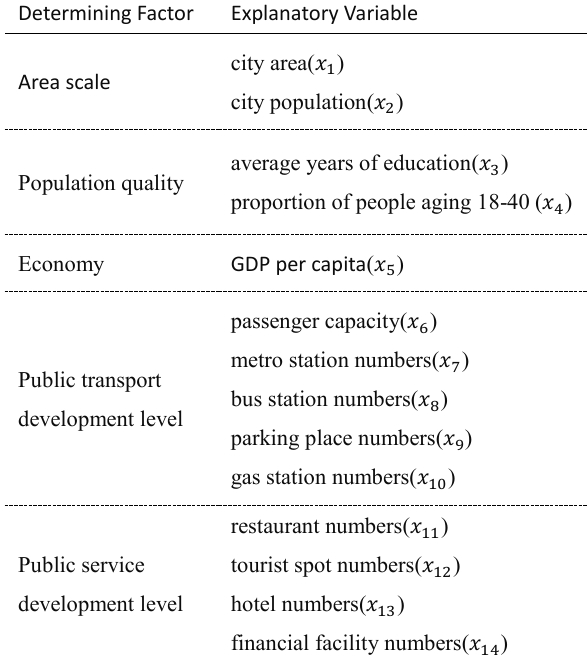
Table 1. Determining factors and explanatory variables of